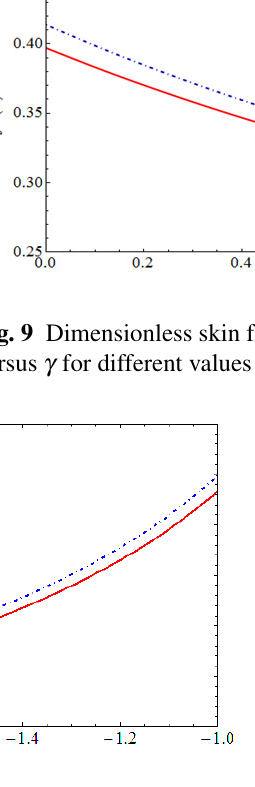
Fig. 10 Dimensionless skin friction coefficient − f (cid:48)(cid:48) ( 0 ) versus δ for different values of C